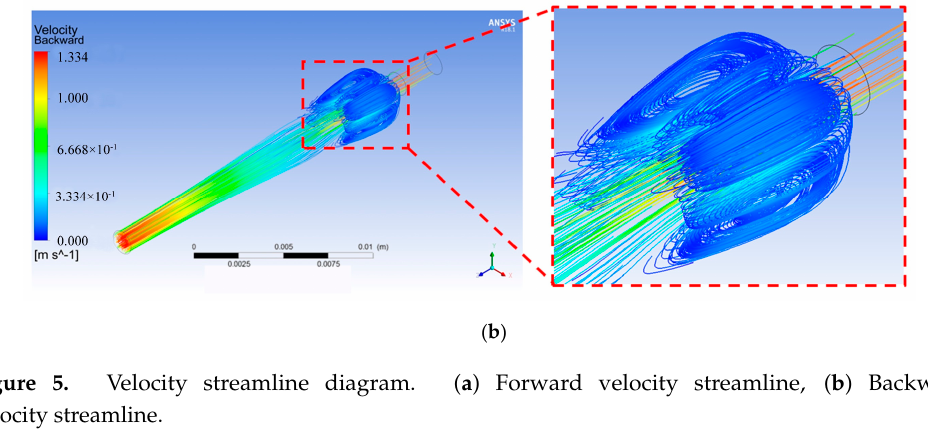
Figure 5. Velocity streamline diagram. ( a ) Forward velocity streamline, ( b ) Backward velocity streamline.